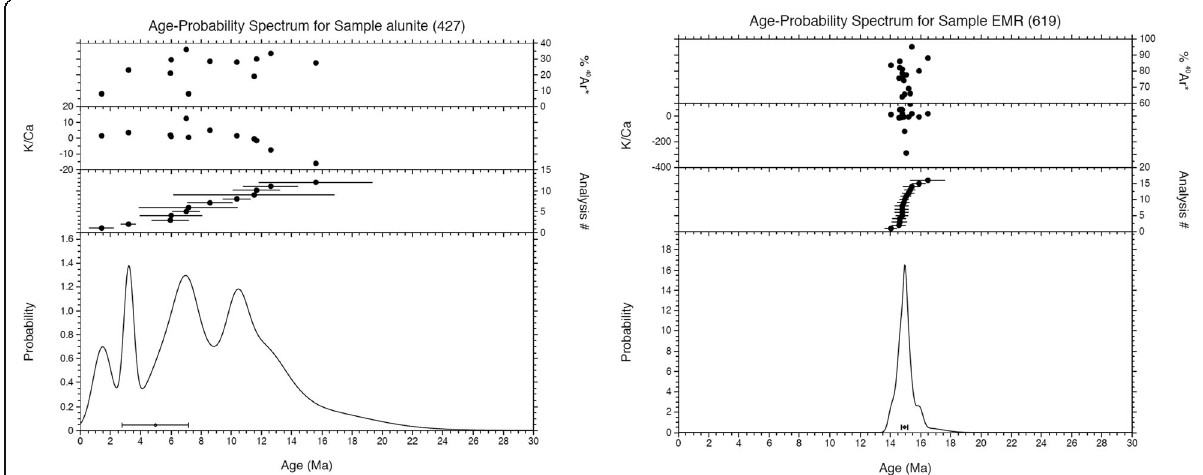
Fig. 5 Age probability diagrams of the alunite sample. Left and right diagrams represent the 40 Ar/ 39 Ar ages of multiple aliquots using the original and modified gas preparation protocol, respectively.